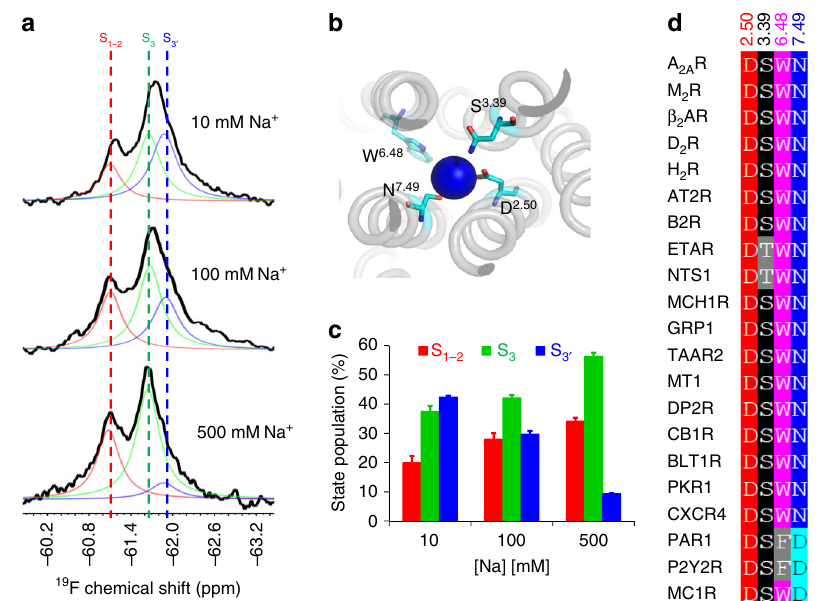
Fig. 1 Allosteric modulation of A 2A R by the monovalent cation Na + . a 19 F NMR spectra of 200 μ M BTFMA-labeled A 2A R-V229C as a function of Na + concentration (10 mM, 100 mM and 500 mM NaCl). Three distinct resonances correspond to inactive (S 1 − 2 , shown in red) and active states (S 3 and S 3 ′ , shown in green and blue, respectively). b Top view showing conserved residues (D 2.50 , S 3.39 , W 6.48 and N 7.49 ) associated with the sodium pocket of A 2A R. c Population histogram of states, S 1 − 2 , S 3 and S 3 ′ , corresponding to spectra shown in ( a ). d Alignment of conserved residues associated with the sodium pocket in class A GPCRs. Error bars are de fi ned based on the difference between the fi tted area associated with the deconvolved spectrum and the area associated with the experimental spectrum. This error bar de fi nition was applied into all spectra without speci fi c